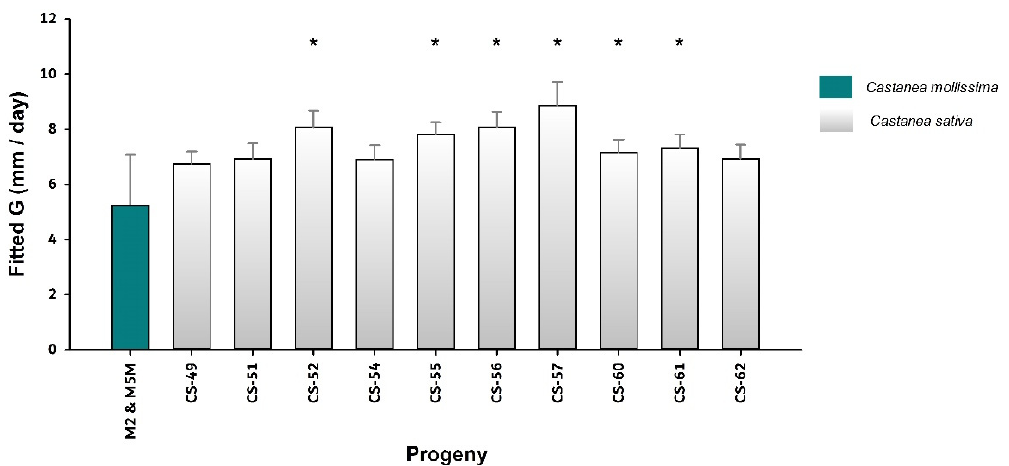
Figure 3. Values of mean daily lesion growth rate (G) of Cryphonectria parasitica on cuttings of Castanea sativa progenies fitted by model Mbp1 (Assay B). Mean values and 95% confidence error are shown. Asterisk (*) denotes significant differences in respect to Castanea mollissima (average value of “M2” and “M5M”). Number of repetitions: 4 (“M2” and “M5M”); see Table 1 for progenies of C. sativa .